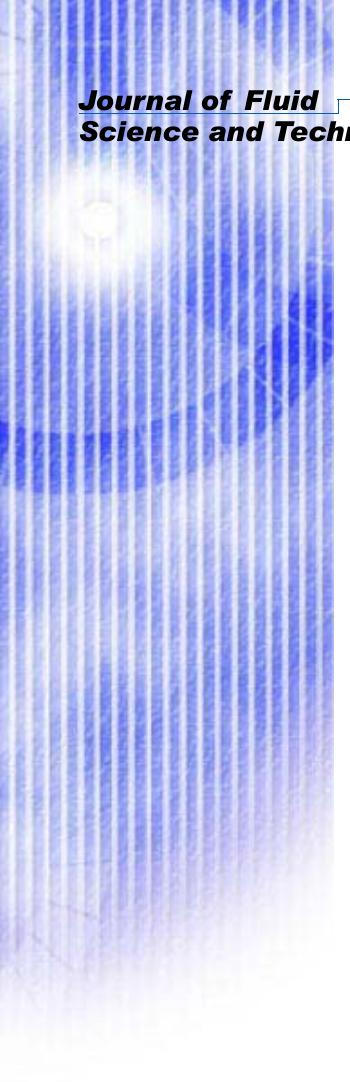
Fig. 12 Streamwise turbulence intensity